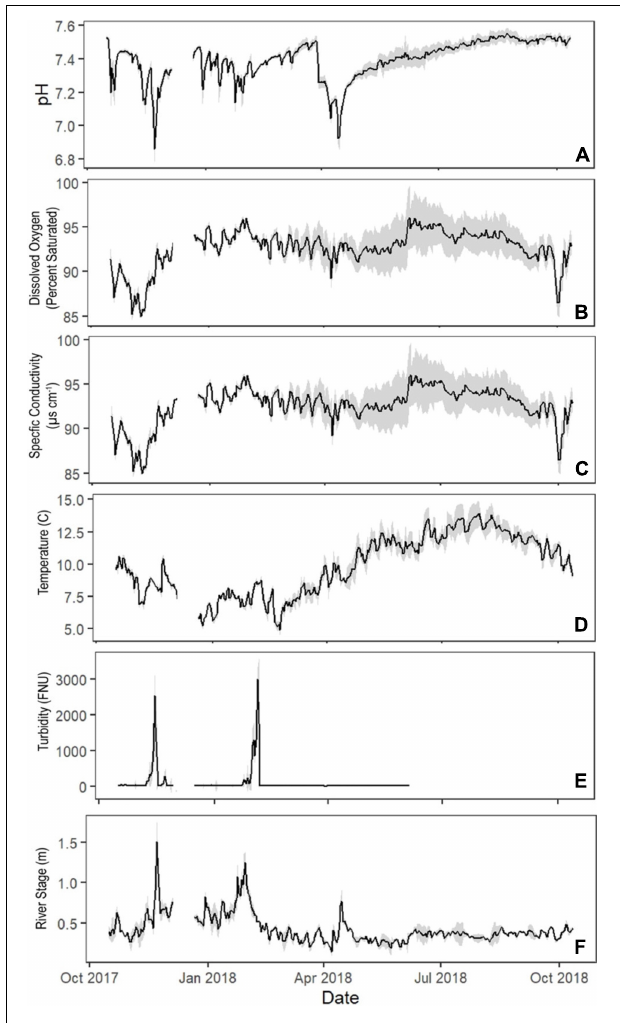
FIGURE 3 | Time series of (A) pH, (B) dissolved oxygen (percent saturated), (C) specific conductivity ( µ S cm − 1 ), (D) temperature ( ◦ C), (E) turbidity (FNU), and (F) river stage (m) over the course of the study period, October 16th, 2017 through October 12th, 2018. Blue background delineates distinct period of storm-driven parameter behavior (greater variability) over the course of the year. Measurements were taken every 5 min from October 16th to December 4th, 2017, and every 15 min from December 21st, 2017 to October 12th, 2018. Turbidity data above the detection range (4000 FNU) were removed, as well as turbidity data after June 15th, 2018 due to a sensor maintenance issue.